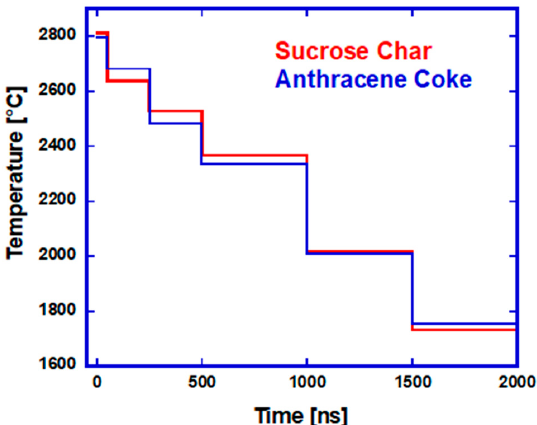
Figure A9. TTHs of sucrose char and anthracene coke—50 mJ/cm 2 .